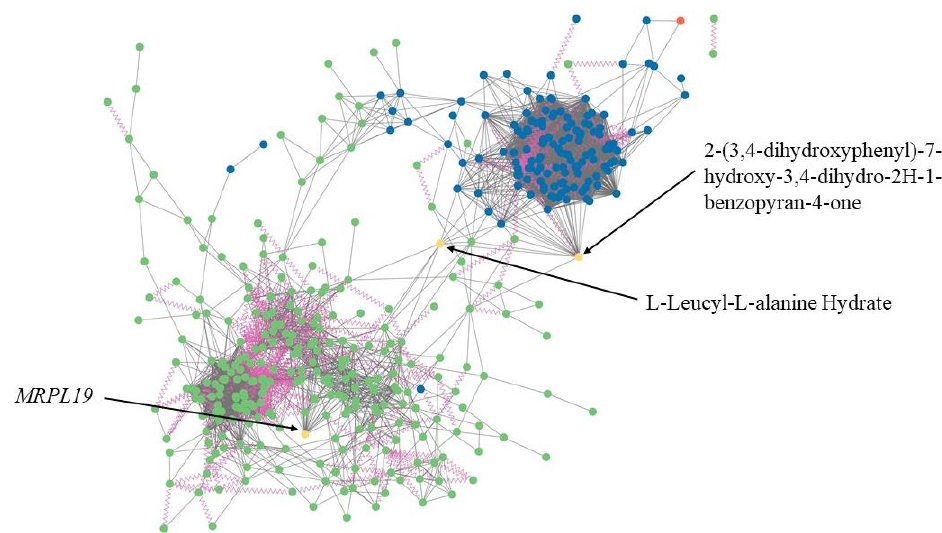
Figure 8. Interaction network of variables selected by RF for integrated analysis of the microbiome and metabolome, where solid lines (grey) and polylines (purple) represent positive correlation and negative correlation, respectively. The blue nodes, orange nodes and green nodes represent metabolites, bacteria species and genes, respectively. The top three nodes with the highest betweenness value are highlighted in yellow.